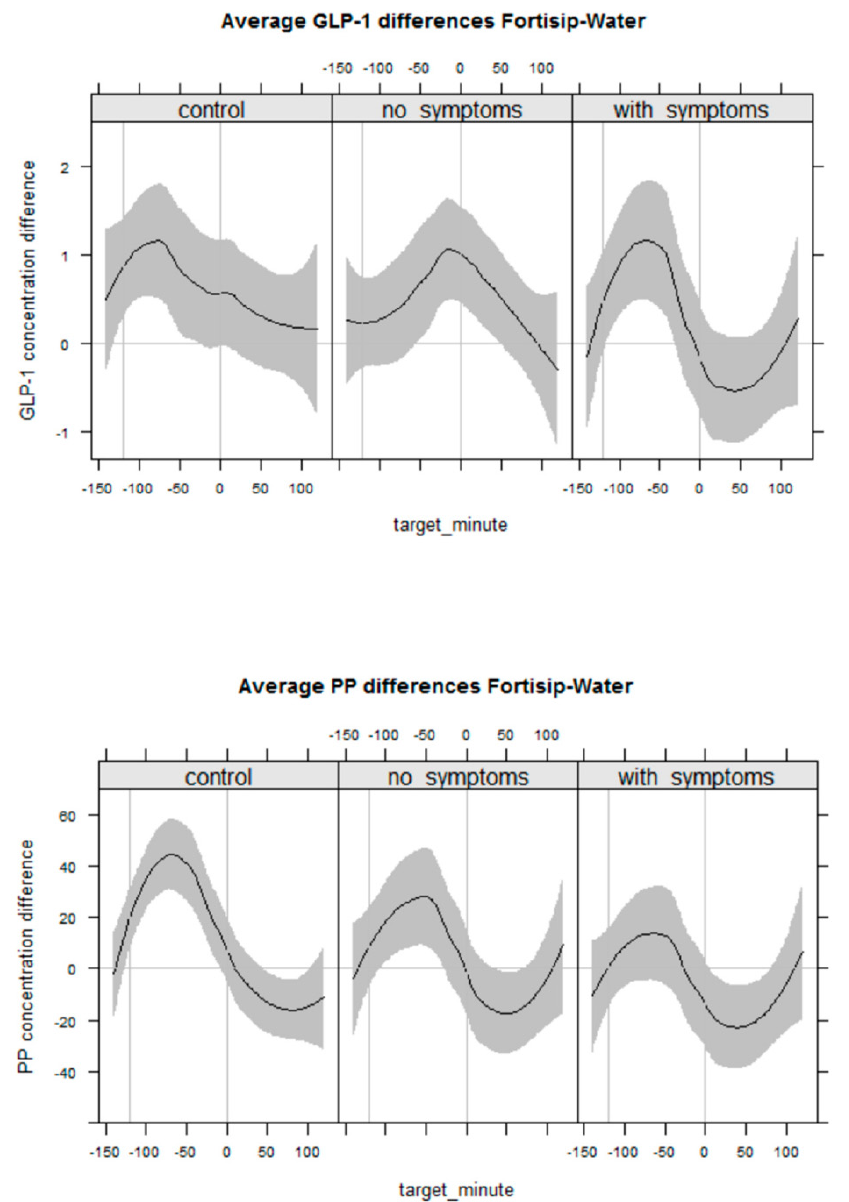
Figure 5. Variation in GI–peptide hormone levels between individuals is large. For this reason, this figure presents the change in mean GLP-1 (upper panel) and PP concentrations (lower panel) during delivery of jejunal nutrition (Fortisip) and water ( − 120 to 0 min.) and after ingestion of the oral test meal (0 to +120 min.), by participant group, with confidence bands before and after jejunal infusion. Positive values indicate greater GLP-1 and PP after the nutritional intervention. GLP-1, glucagon-like peptide-1; PP, pancreatic